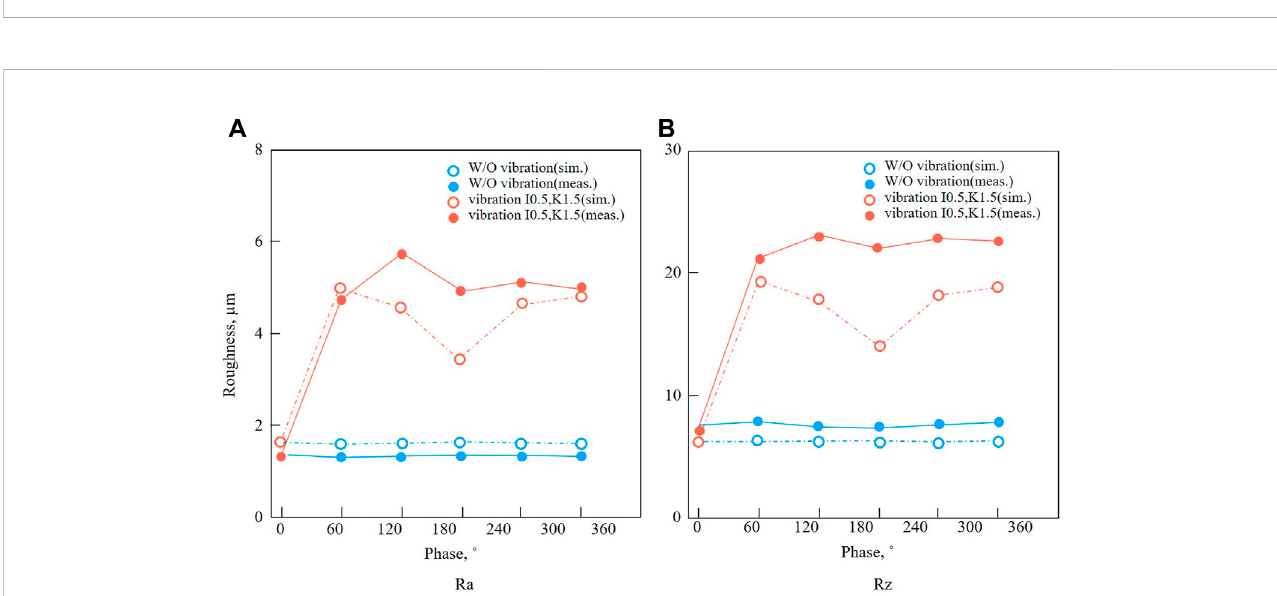
FIGURE 3 Prediction of surface roughness by low-frequency vibration ( I = .5 and K = 1).